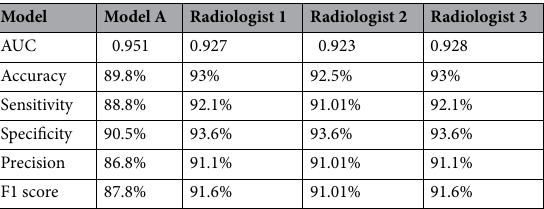
Table 6. AI model and Radiologist performance comparisons on the lateral elbow test